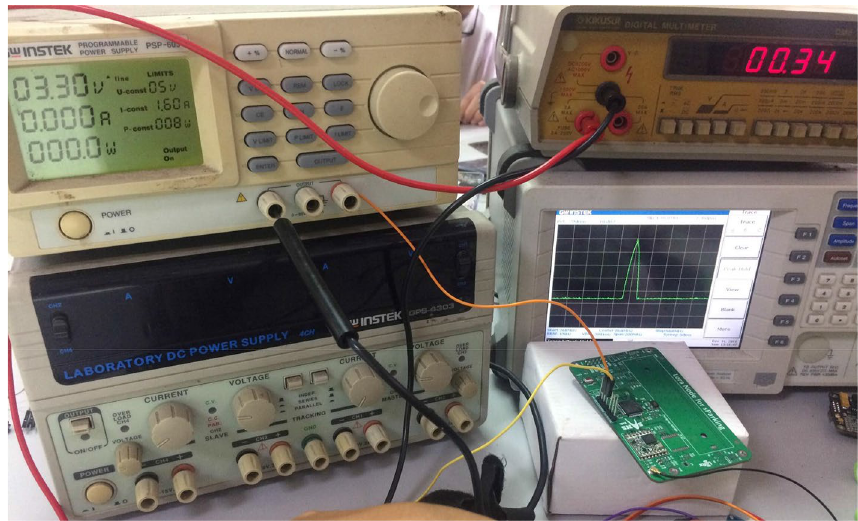
Figure 24. Lora node performance test and power consumption measurement.